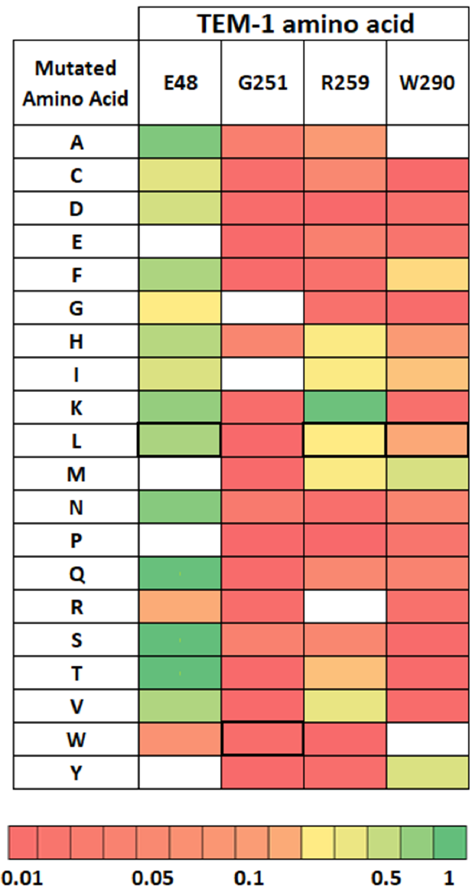
Figure 4. Selective mutational effect of mutations in the 3 amino acids found exclusively in the G251 group ( n = 8) (E48, R259, and W290). Fitness was obtained by using Firnberg’s data on TEM-1 [8]. A fitness of 1 (green) corresponds to the fitness of the wild-type allele (TEM-1). A fitness of 0 (red) corresponds to a minimum fitness. The color gradient from green to red corresponds to the fitness gradient. The boxed mutations correspond to amino acids present in CTX-M-15.